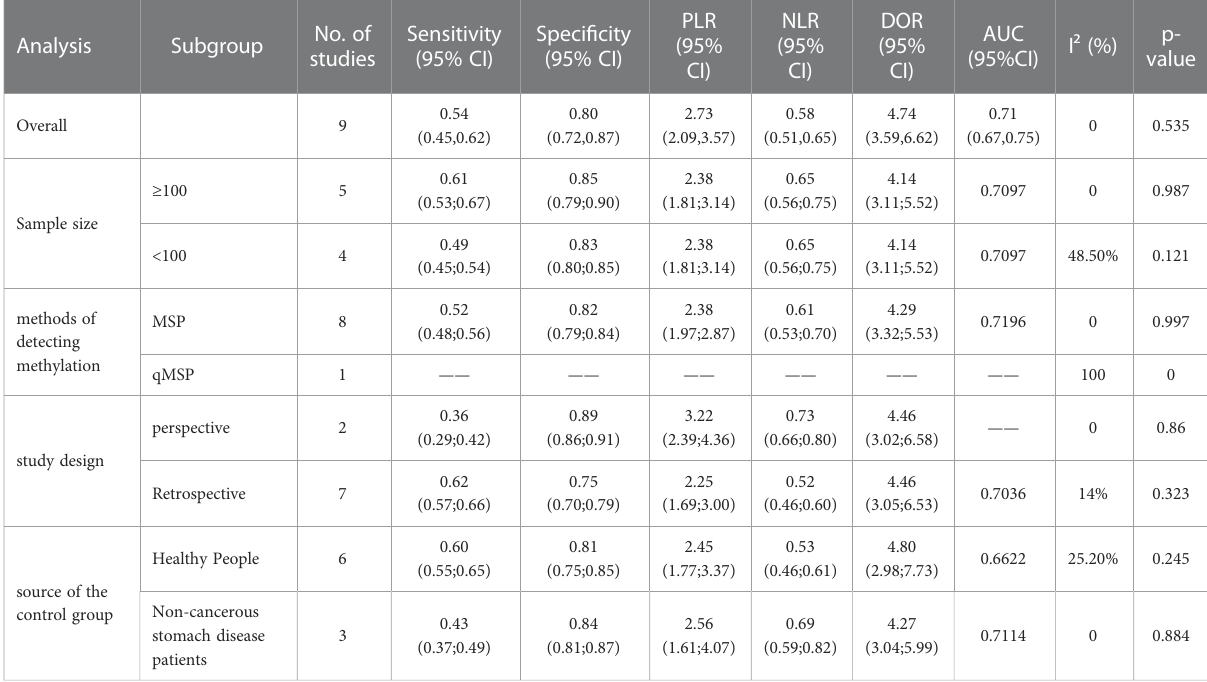
TABLE 3 Results of subgroup analysis of RNF180 gene methylation were reported from nine studies in a diagnostic meta-analysis.